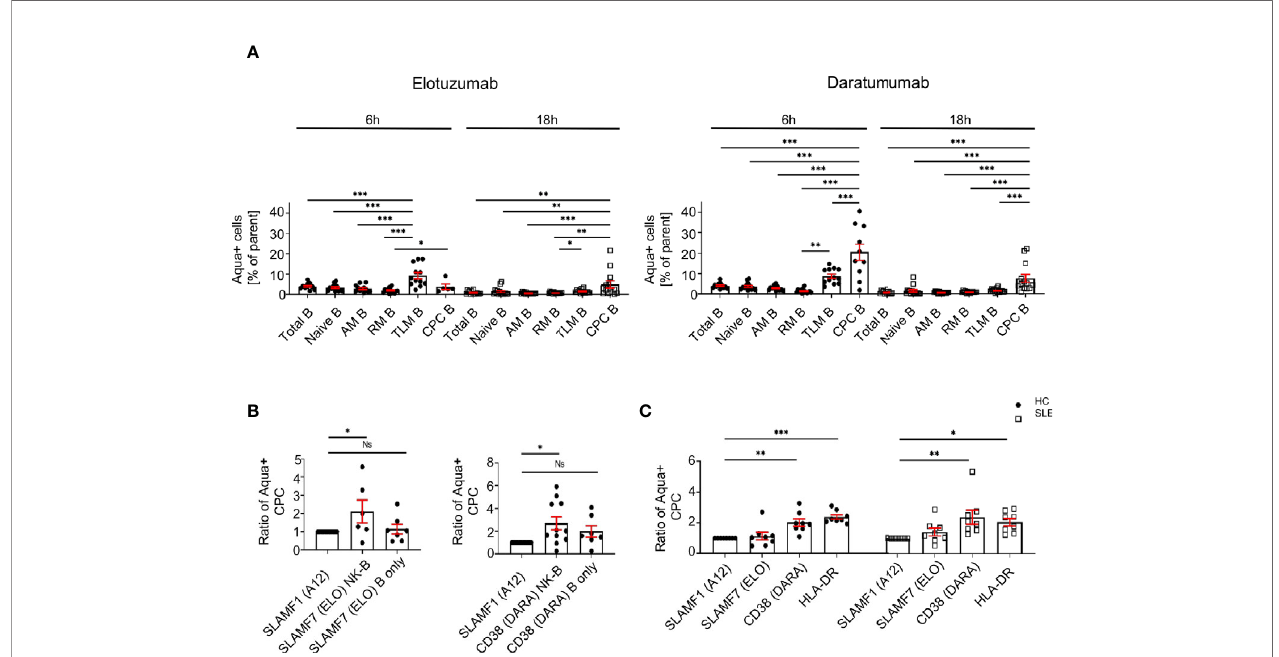
FIGURE 6 | Activation of SLE NK cells with mAb directed against CD38 and SLAMF7 promotes the killing of peripheral blood plasma cells. (A) Frequency of dead cells in a NK-B cell co-culture system after 6h (N=14) and 18h (N=16) following stimulation with SLAMF1, elotuzumab or daratumumab (one-way ANOVA with Tukey ’ s multiple comparison test). (B) Fold increase of dead circulating plasma cells following stimulation with daratumumab 6h (N=12) or elotuzumab 18h (N=7) in either B cells alone or B cells co-cultured with pre-stimulated NK cells (one-way ANOVA with Sidak ’ s multiple comparison test) (C) Ratio of dead cells over control condition after 6h stimulation with elotuzumab or daratumumab in HC and SLE patients (HC=8, SLE=8; two-way ANOVA, Sidak ’ s multiple comparison test). Data represent mean ± SEM (*P < 0.05, **P < 0.01, ***P < 0.001). HC=healthy